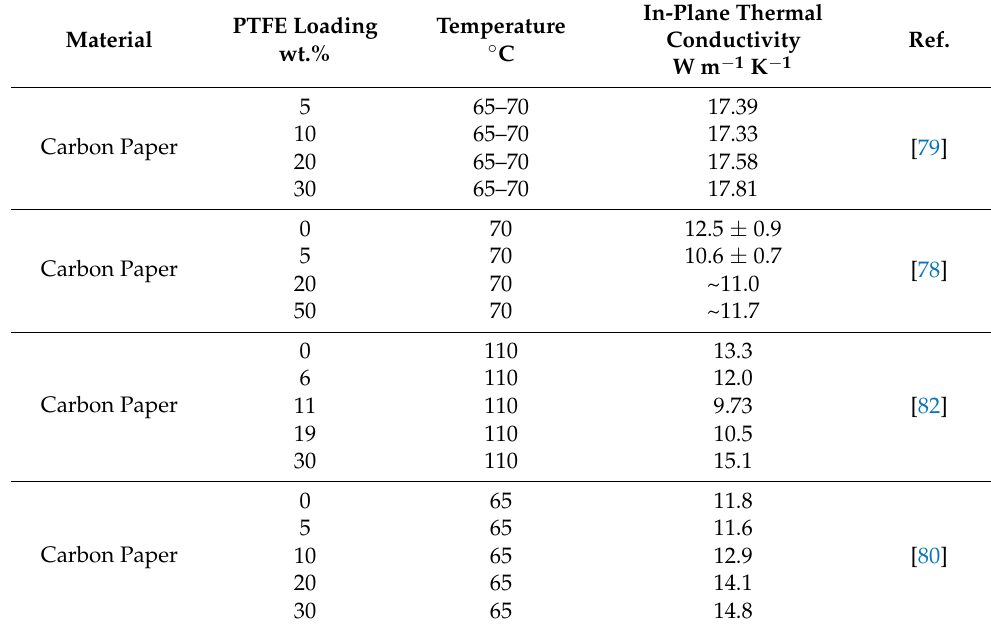
Table 1. In-plane thermal conductivity values measured for GDLs with varying PTFE content.